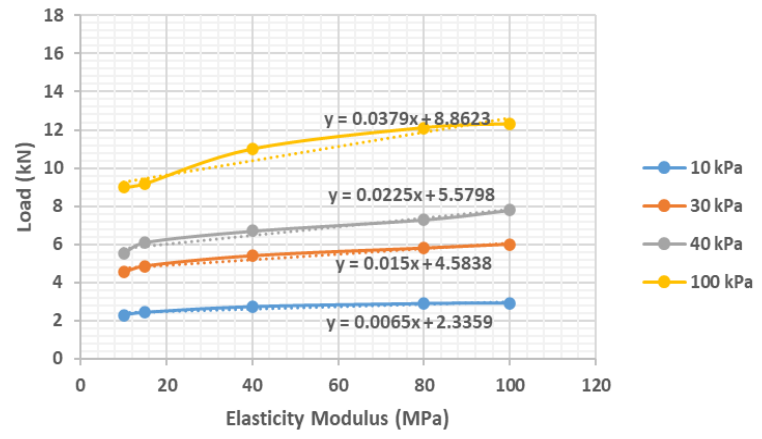
Figure 3. Elasticity modulus versus ultimate load for CHSB 0 pile.